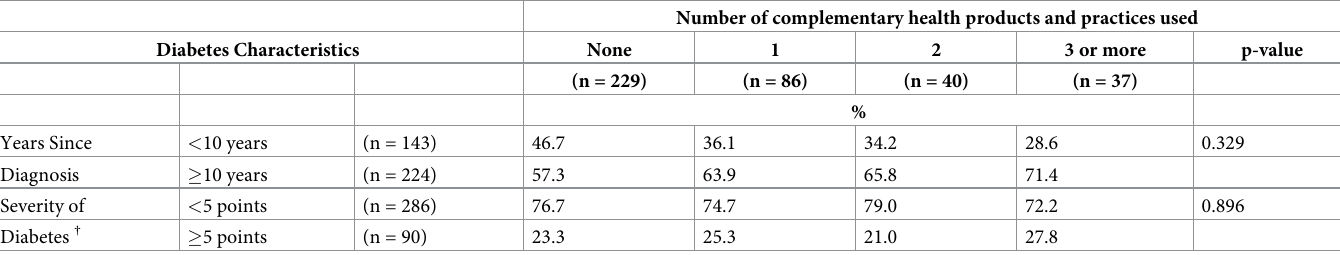
Table 2. Use of complementary health products and practices by years since diagnosis of diabetes and severity of diabetes over the past 12 months. Number of complementary health products and practices used Diabetes